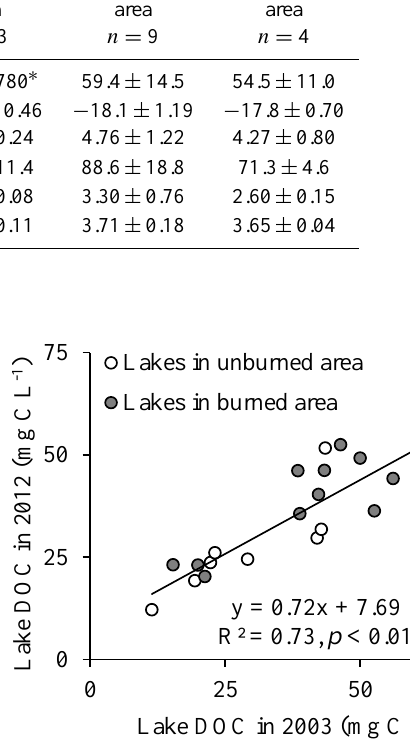
Fig. 5. Comparison of lake DOC concentrations in 2012 and 2003, where a subset of the lakes are located within a 2011 fire perimeter. Individual trend lines for lakes in burned and unburned areas were not different (ANCOVA, F 1 , 19 = 0.51, p = 0.52), and a single trend line is